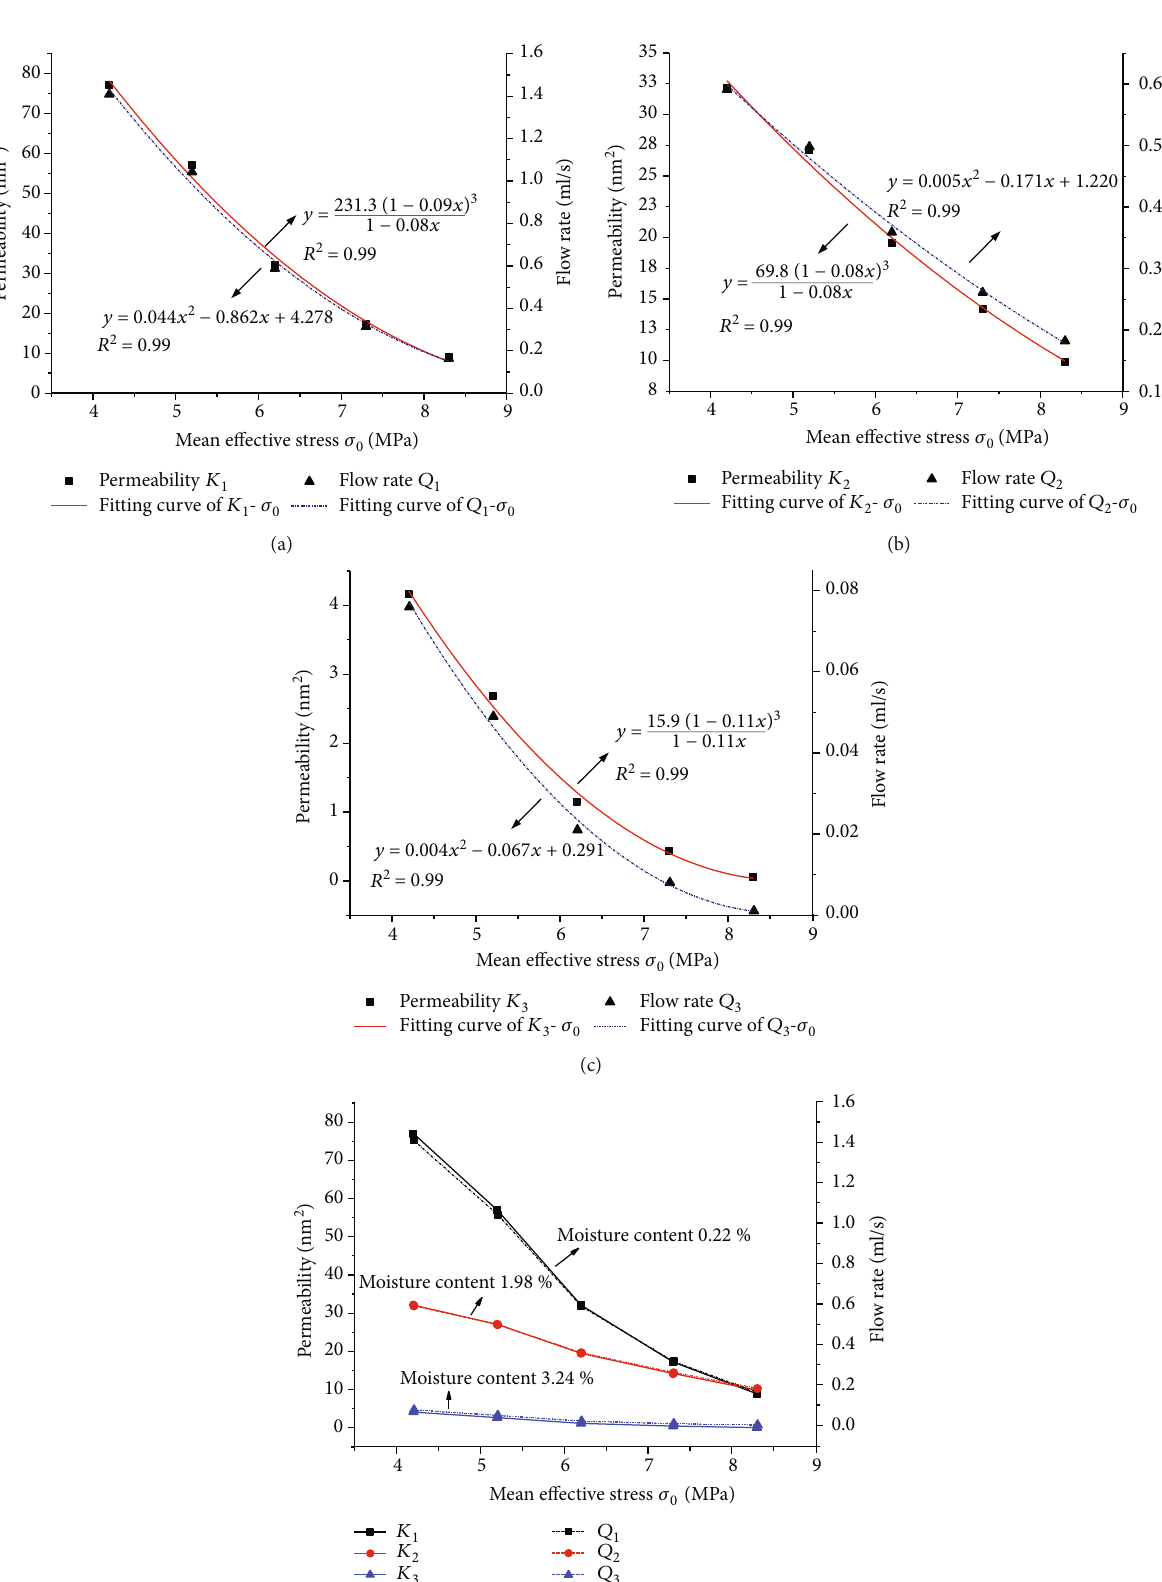
Figure 7: K − σ and Q − σ curves of samples with di ff erent moisture contents: (a) moisture content 0.22%; (b) moisture content 1.98%; (c) 0 0 moisture content 3.24%; (d) total